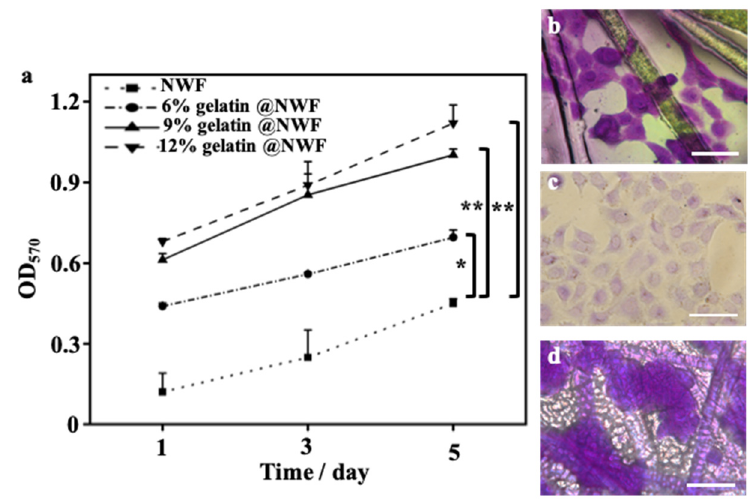
Figure 3. Cell compatibility of gelatin@NWF. ( a ) MTT assay characterized DU 145 cells proliferation on hybrid scaffold prepared from different concentrations of gelatin, * denotes p < 0.05, ** denotes p < 0.01; bright-field images of crystal violet-stained DU 145 cells grown on ( b ) gelatin@NWF ( − 80 °C), ( c ) tissue culture plate (TCP), and ( d ) gelatin@NWF, scale bar = 50 µm.